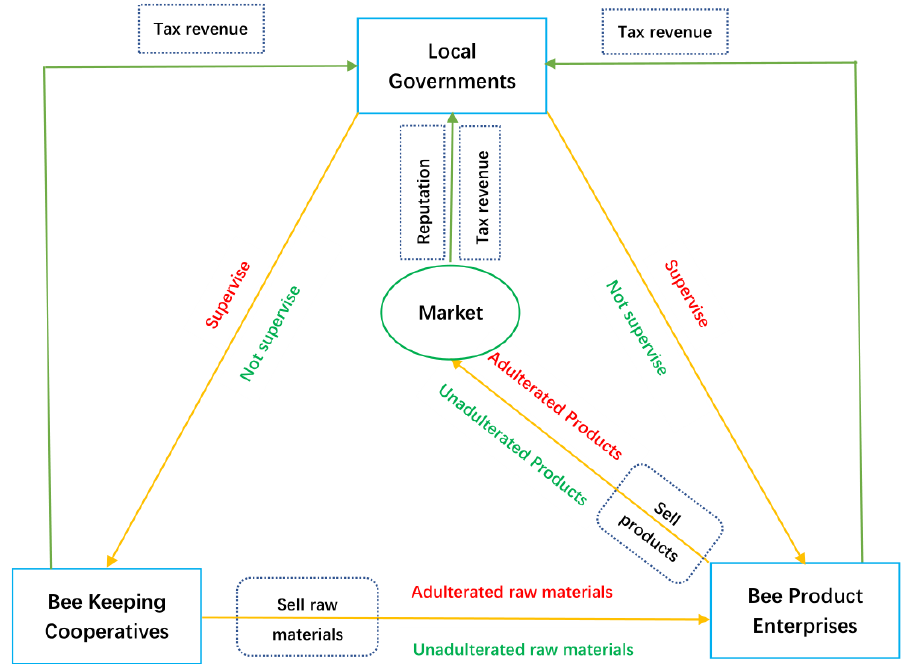
Figure 1. The relationships between different stakeholders in the SHP-game model.